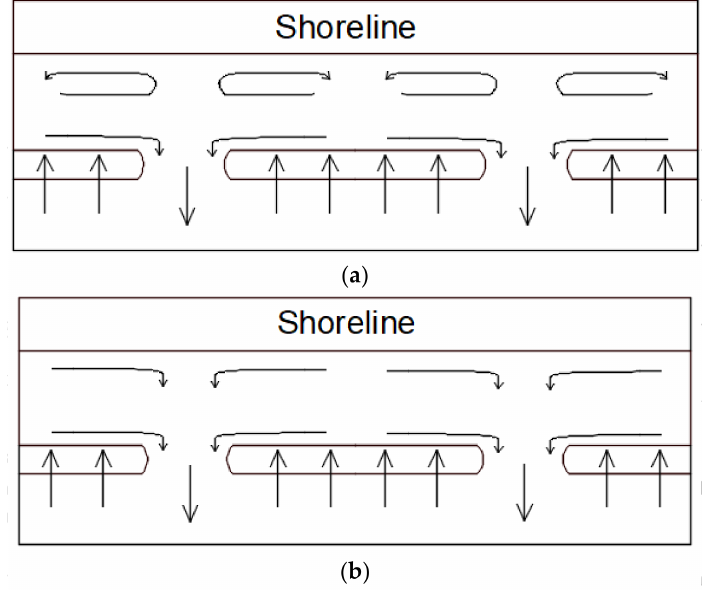
Figure 5. ( a ) Accretive circulation pattern ( b ) Erosive circulation